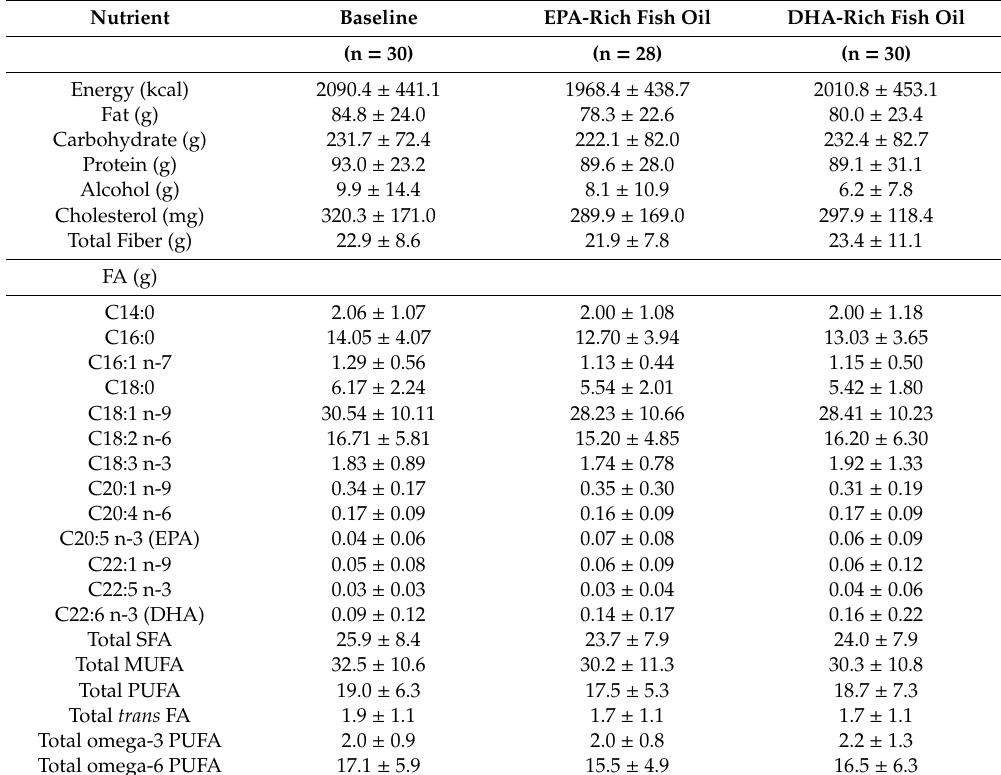
Table 3. Average energy and nutrient consumption without supplements based on 7-day food records before and after intervention.